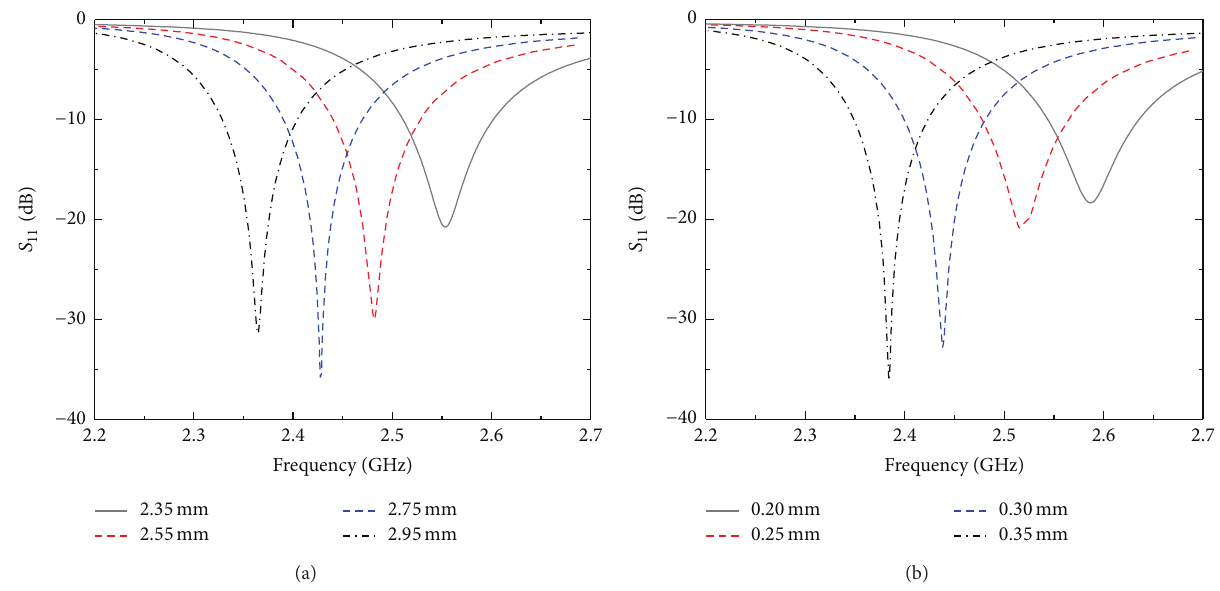
Figure 3: Simulated 𝑆 11 of single metamaterial antenna for different values of (a) 𝑙 3 and (b) 𝑠 2 .